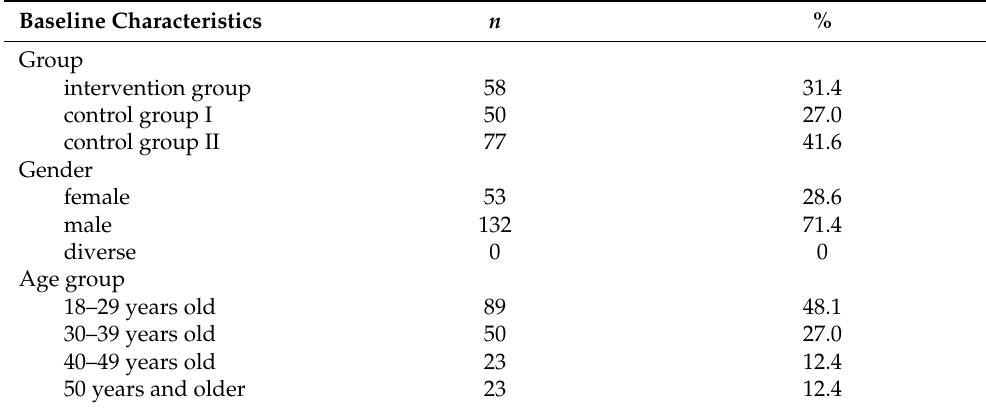
Table 1. Descriptive data of the sample ( N =